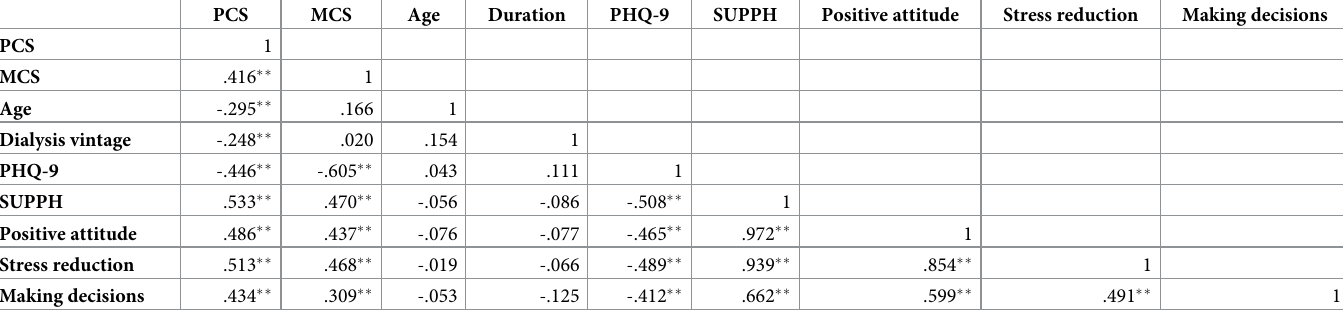
Table 4. Pearson correlations among demographics, depression (PHQ-9), self-care self-efficacy subscales (SUPPH subscales) and two components of QoL (PCS and MCS) (n =